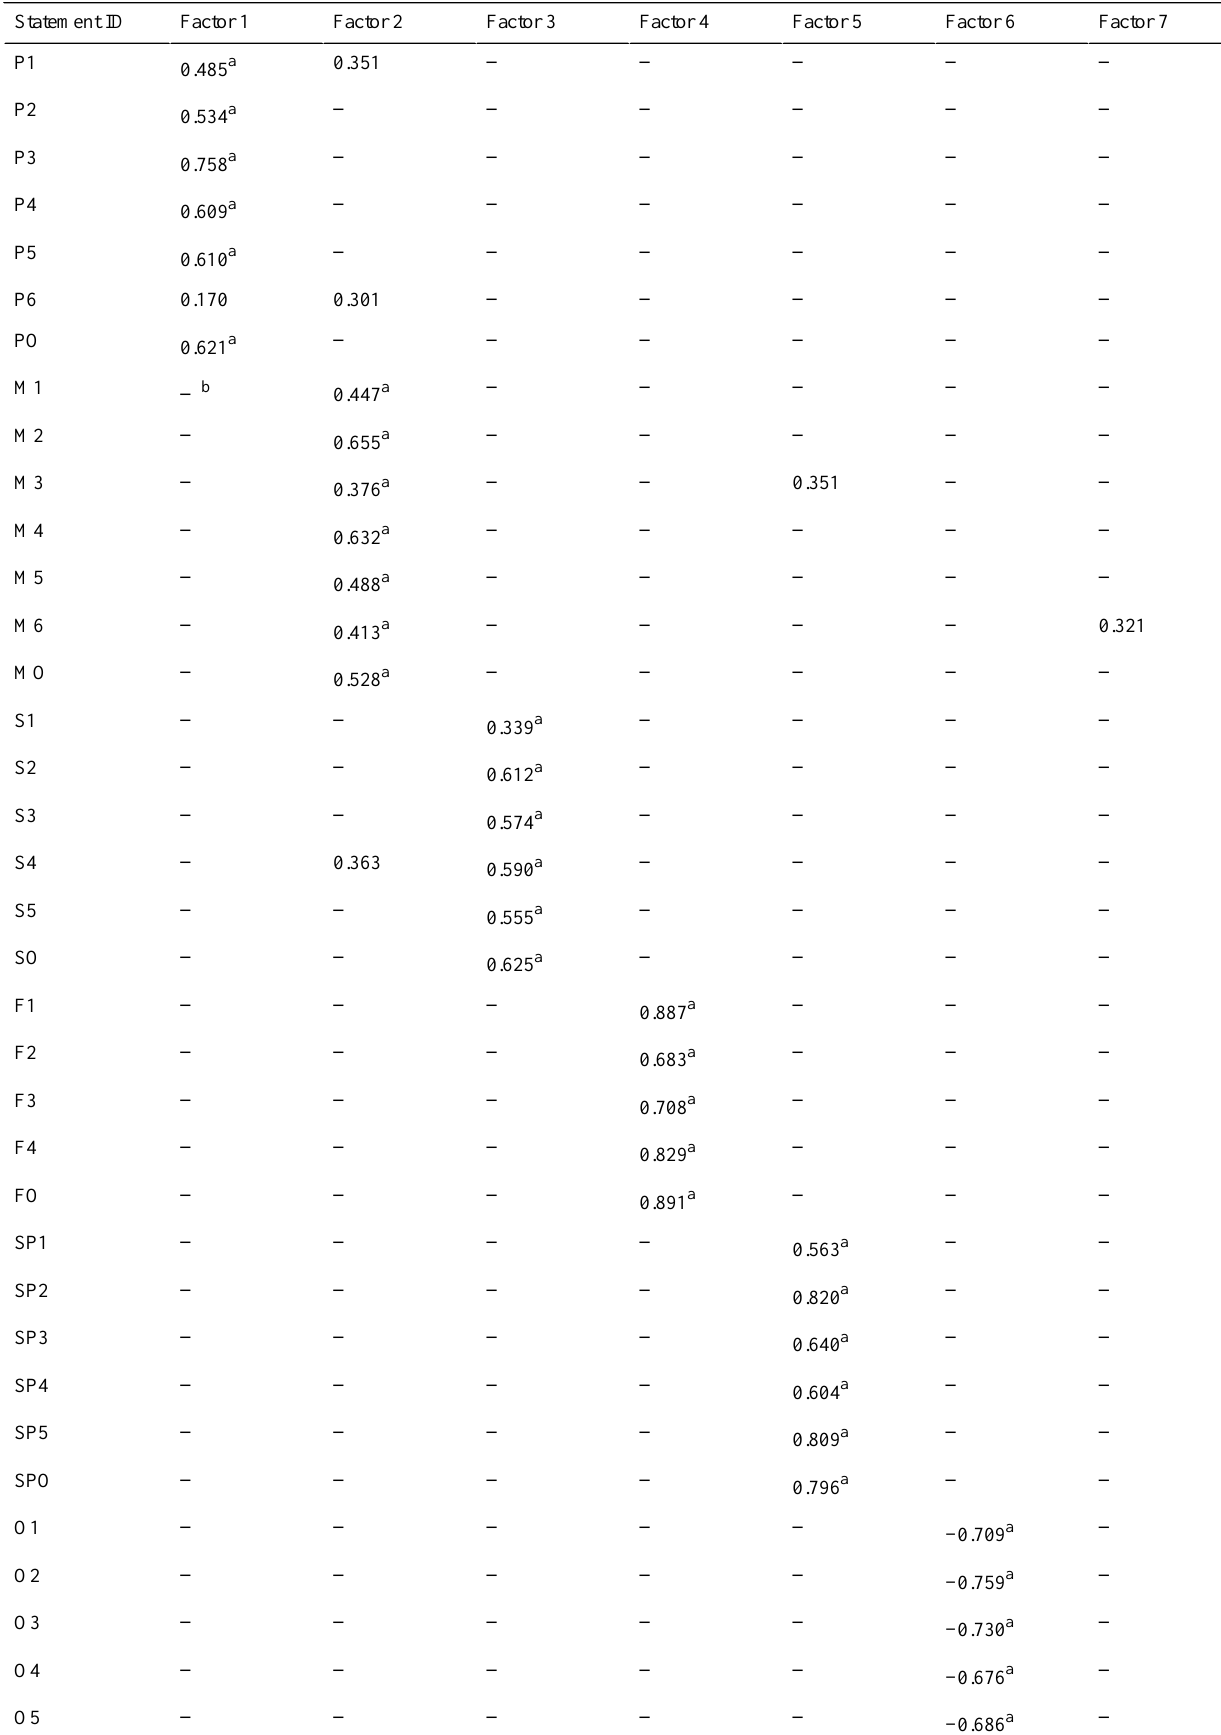
Table 5. Rotated factor loadings of the exploratory factor analysis with 44 statements from 546 study